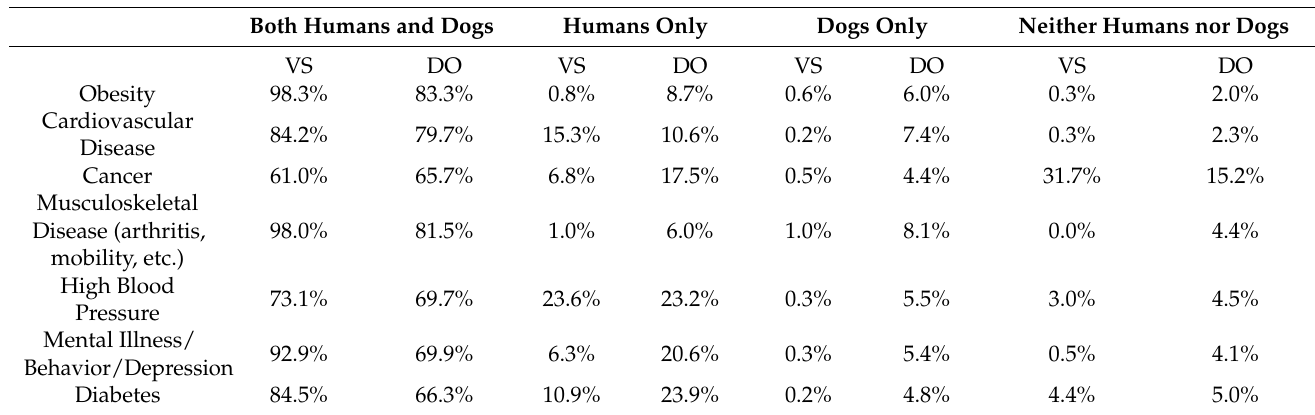
Figure 1. Dog owner (DO; n = 1028) and veterinary staff (VS; n = 722) ratings of the importance of physical activity for ( a ) dog health and ( b ) human health. Table 1. Dog owner (DO; n = 1028) and veterinary staff (VS; n = 631) beliefs about the usefulness of physical activity (PA) for preventing disease. Disease Type